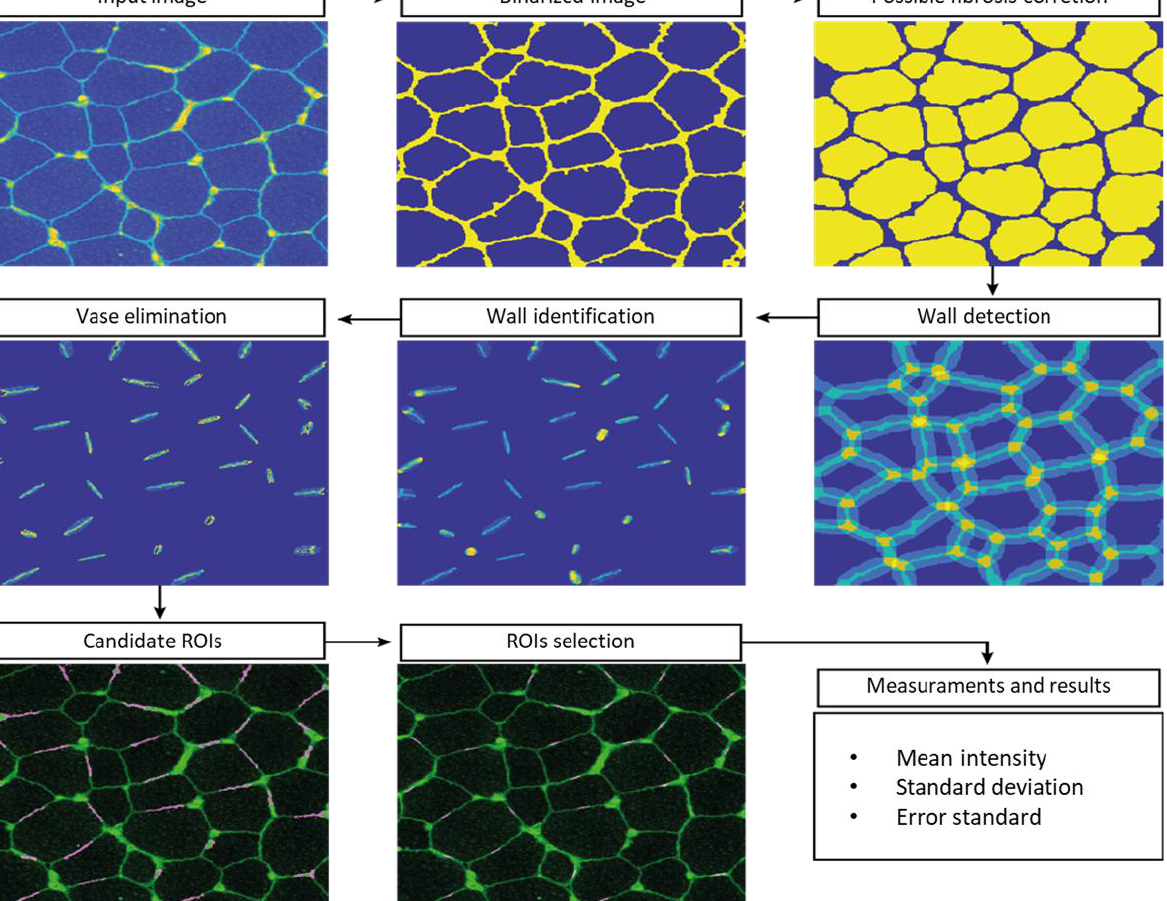
Figure 6. Automatic analysis pipeline on an example image.